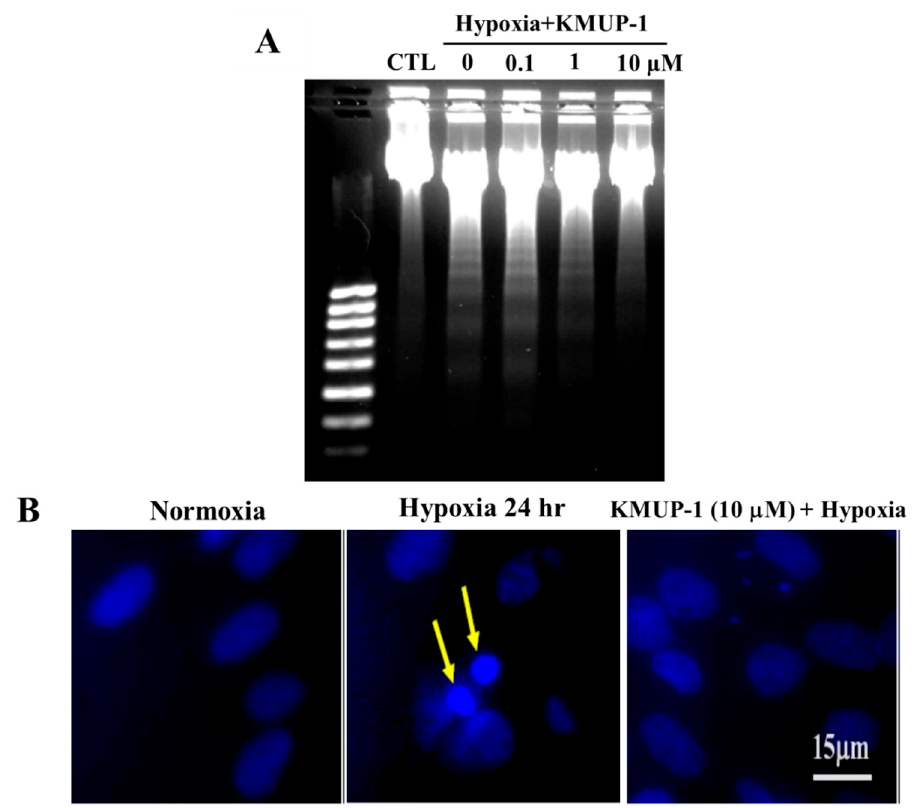
Figure 3 . Apoptotic evaluation of H9c2 cardiomyoblasts. ( A ) DNA ladder assay of H9c2 cardiomyoblasts; normoxia (lane 1; CTL), hypoxia (lane 2), hypoxia with 0.1 μ M KMUP-1 (lane 3), hypoxia with 1 μ M KMUP-1 (lane 4), and hypoxia with 10 μ M KMUP-1 (lane 5). ( B ) The effect of 10 μ M KMUP-1 on hypoxic H9c2 cardiomyoblasts (Hoechst 33342 staining, original magnification × 400). The condensed and fragmented H9c2 cells’ nuclei and apoptotic bodies (arrows) are seen in hypoxic-H9c2 cell, but not in the normoxia and KMUP-1 treatment.